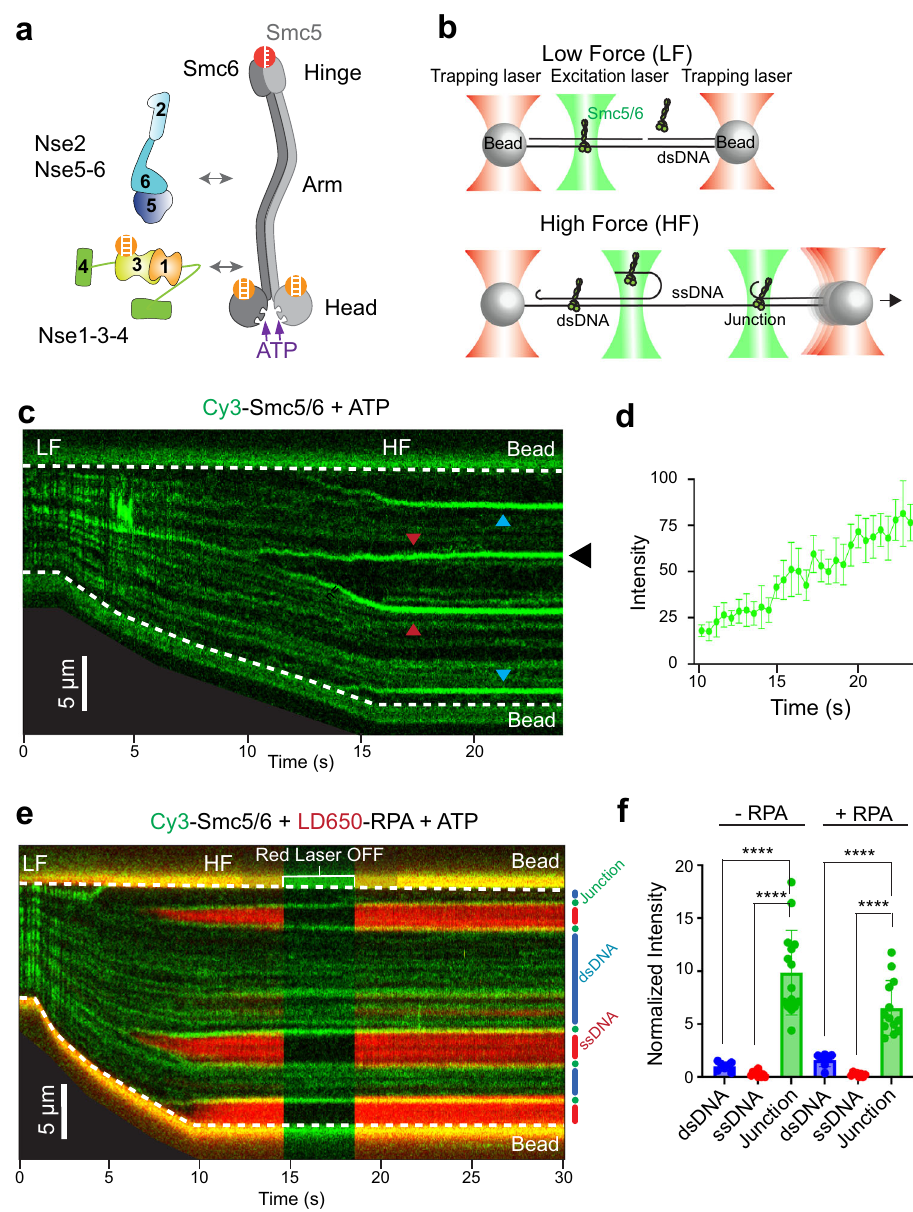
Fig. 1 | Smc5/6 exhibits distinct binding behaviors on three types of DNA. a Architecture of the S. cerevisiae Smc5/6 complex, which is composed of a Smc5- Smc6 heterodimer and six other subunits (Nse1-6). Orange symbols indicate regionsofSmc5/6knowntobinddsDNA.Theredsymbolindicatesaregionknown tobindssDNA. b Schematicofthesingle-moleculeexperimentalsetupunderalow- force(LF)orhigh-force(HF)regime.MultipleformsofDNAco-existedonthesame tether in the HF regime due to force-induced DNA peeling. The DNA binding behaviorof fl uorescentlylabelledproteinswasmonitoredbyconfocalmicroscopy. c Representativekymographofa λ DNAtetherbeingstretchedfromLFtoHFinthe presence of 20nM Cy3-Smc5/6 (green) and 2mM ATP. Red arrows indicate twin- streaksemergingfromaninternalDNAnick,andbluearrowsindicatesinglestreaks emerging from untethered DNA termini. d Quanti fi cation of the Smc5/6 fl uores- cence signals at a junction DNA site (marked by the black arrow in panel c ) over time. Data points indicate the averaged photon count per frame ( n =10 frames) at